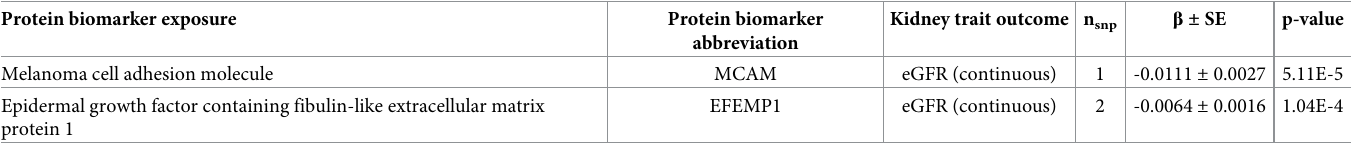
Kidney trait outcome n snp abbreviation